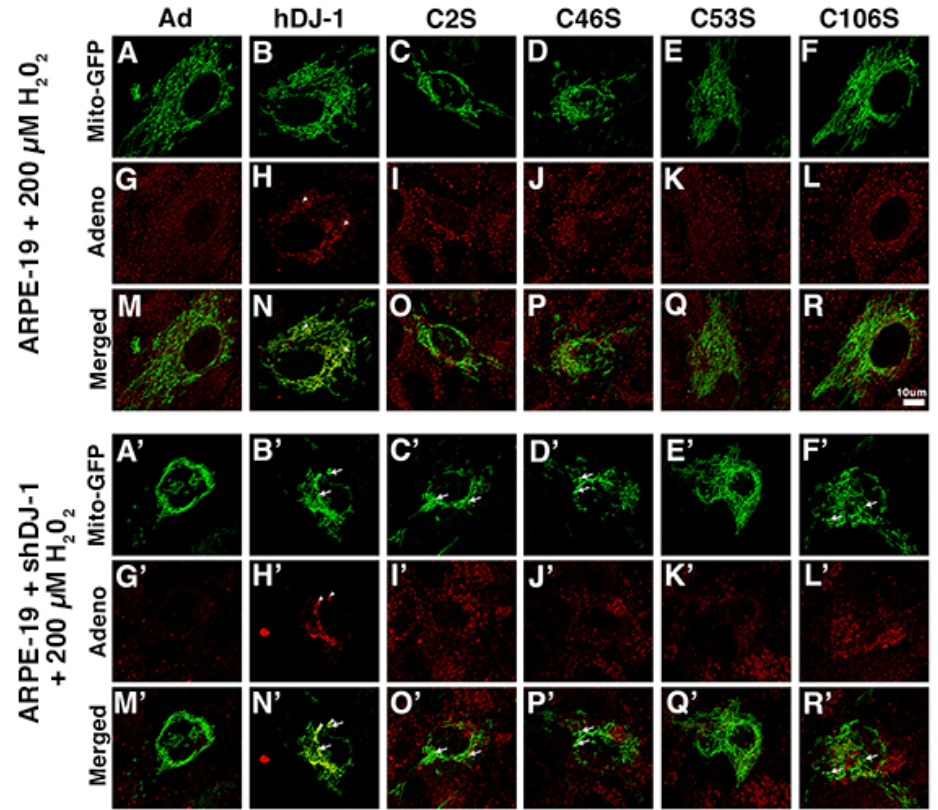
Figure 6. Transduction of several DJ ‐ 1 constructs in ARPE ‐ 19 + shDJ ‐ 1 monolayers under oxidative stress conditions induces mitochondria concentrated in the center of the RPE cells. ( A – R ) ARPE ‐ 19 and ( A’ – R’ ) ARPE ‐ 19 + shDJ ‐ 1 monolayers transduced with CellLight ® mito ‐ GFP (green, A – F and A’ – F’ ) and stained with adenovirus type 5 (red) in baseline conditions. Arrows = dilated tubules; arrowheads = adenovirus (exogenous DJ ‐ 1). Bar = 10  m. Post ‐ imaging processing using